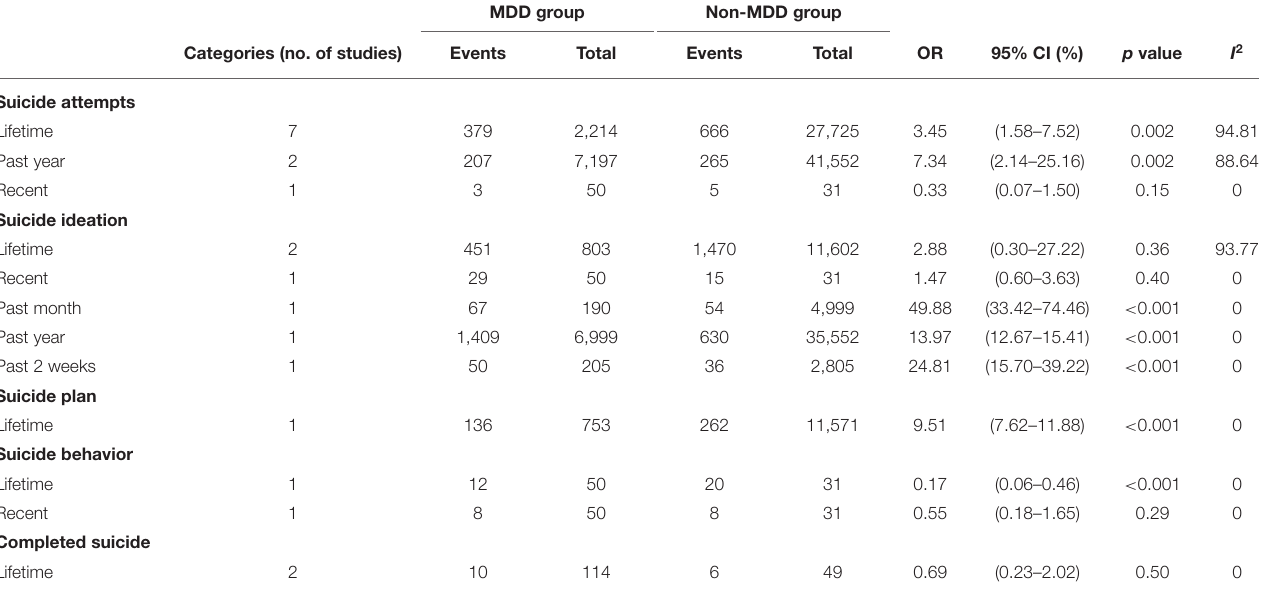
TABLE 2 | Summary of overall prevalence of suicide behaviors between the MDD group and non-MDD